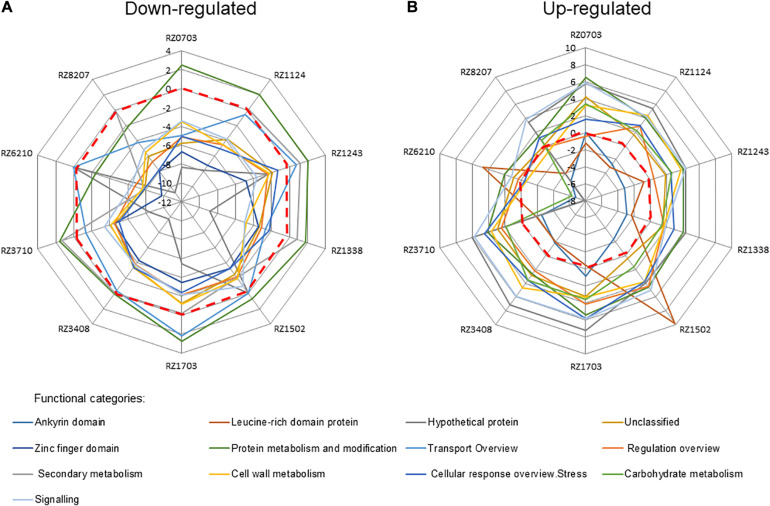
Relative relevance of functional categories of down-regulated (A) and up-regulated (B) DEGs (as in Supplementary Table 6) in 10 chosen Aragonez clones, by MapMan analysis. Values correspond to the average log2(gene expression ratio) of all DEGs in the mentioned functional category.